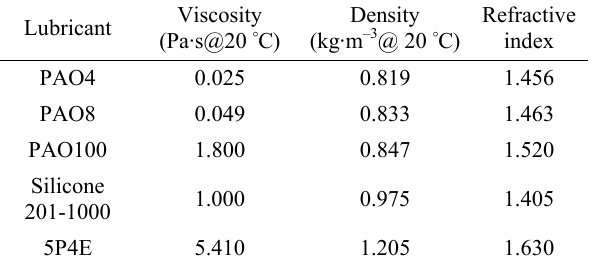
Table 1 Properties of the lubricants used in the